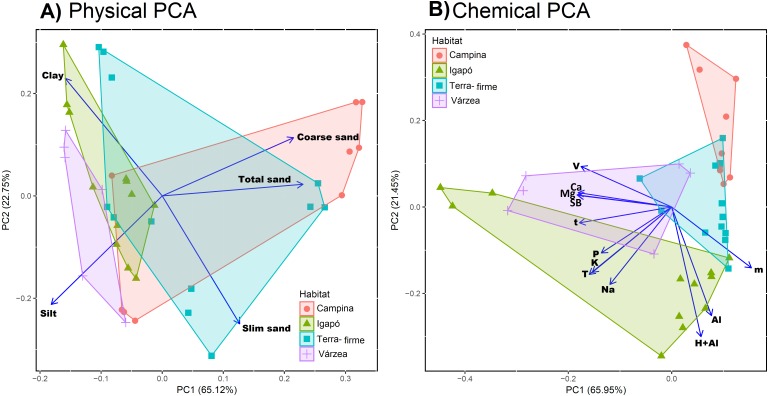
Physical and chemical soil similarity of sample sites across Amazonia.The figure shows the study sites—coloured by habitat type—on the first two axes of a Principle Component Analysis for (A) physical properties (silt, clay and fine, coarse, and total sand fraction) and (B) chemical proprieties (phosphorus (P), exchangeable bases (Na, K, Ca, and Mg), the sum of all exchangeable bases (SB), exchangeable aluminium (Al and H+Al), saturation index by aluminium (m), base saturation index (V), effective cation exchange capacity (t), and cation exchange capacity (T)). The blue rows show the values of each variable loadings in the two firs PCs. For physical PCA we can observe that flooded forest (igapós and várzeas) are associated with negative values in the first PC axis and a more spread distribution of terra-firme and campinas. For chemical PCA there is no separation of flooded forest, but campinas group in most positive values in the first PCA axis followed by terra-firmes.